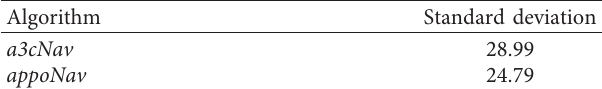
Figure 3: Reward achieved by the artificial agent in nav_maze_static_01 . Table 4: Standard deviation of the reward in nav_maze_static_01